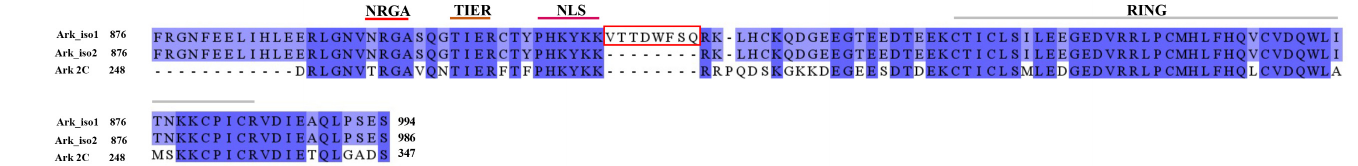
Figure 9. Alignment of Arkadia isoform 1, Arkadia isoform 2 and Arkadia 2C produced by Jalview and colored according to their similarities in amino acids sequence (dark blue for conserved residues, medium dark blue for conserved type of residues and no color for non-conserved residues). Red box: amino acids which do not appear in Arkadia isoform 2 and Arkadia 2C.